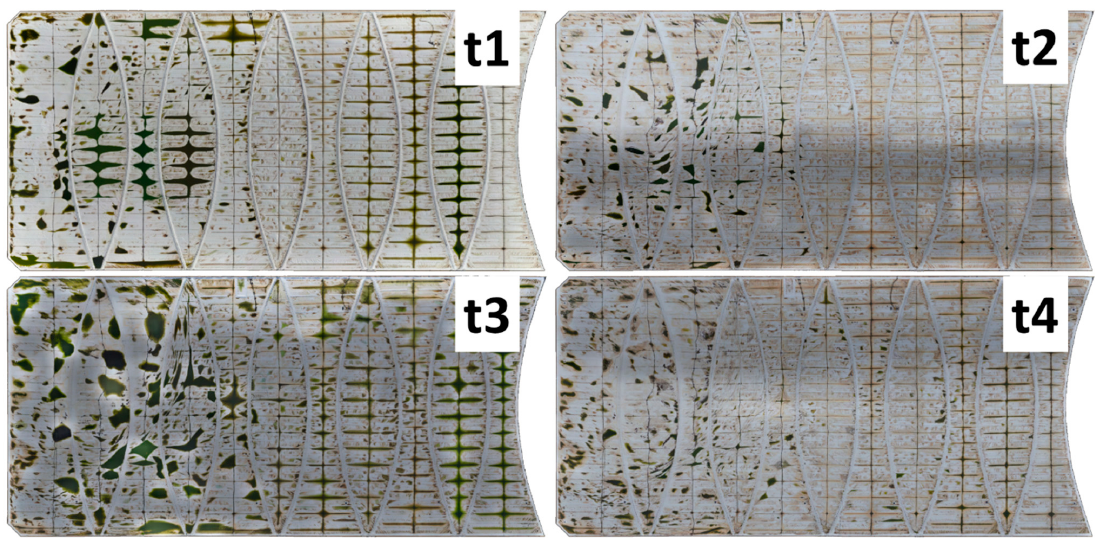
Figure 9. Orthophoto of floating cover from t1 to t4.